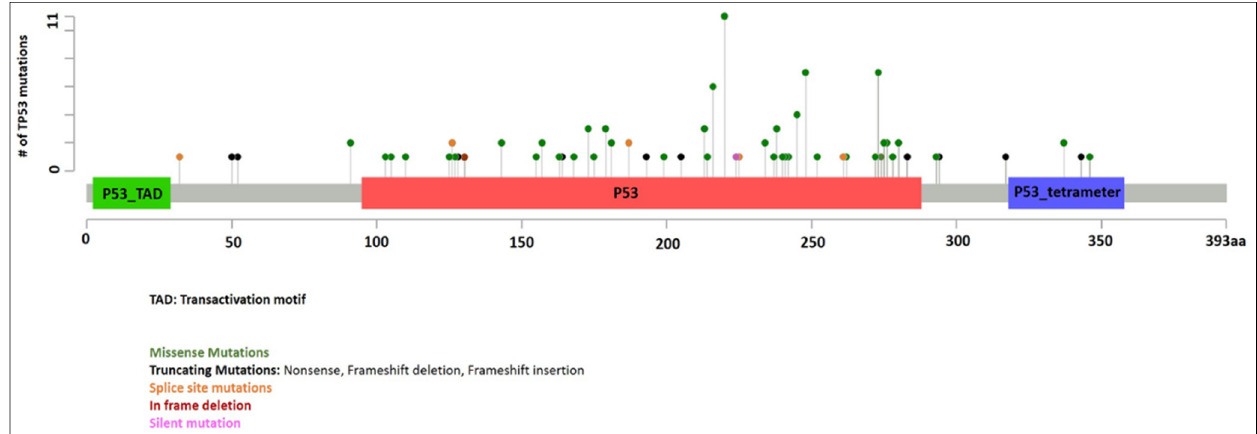
Figure 1. TP53 mutations identified in our cohort.